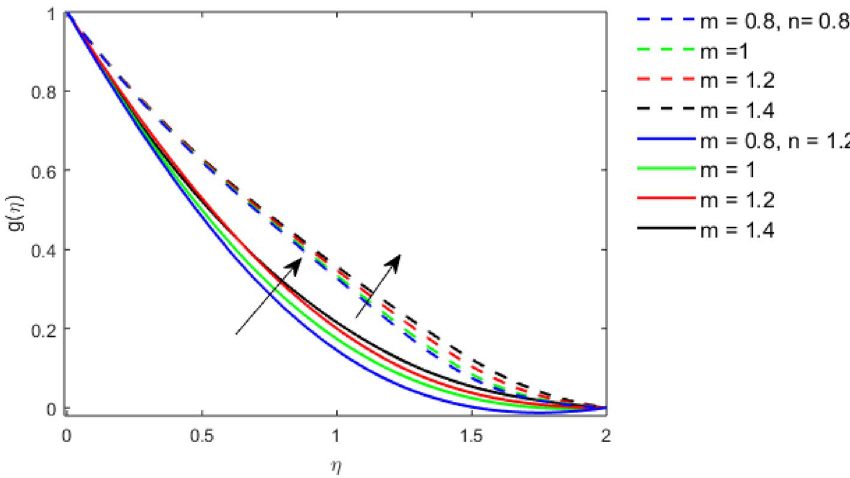
Figure 7. The Tangential velocity profile for increasing thickness index m of disk for Pseudoplastic and dilatant fluid.